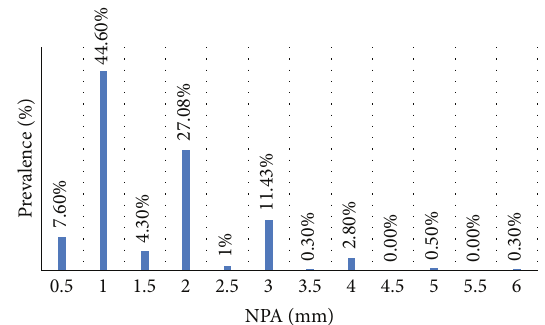
Figure 2: Distribution of the NPA in the population.